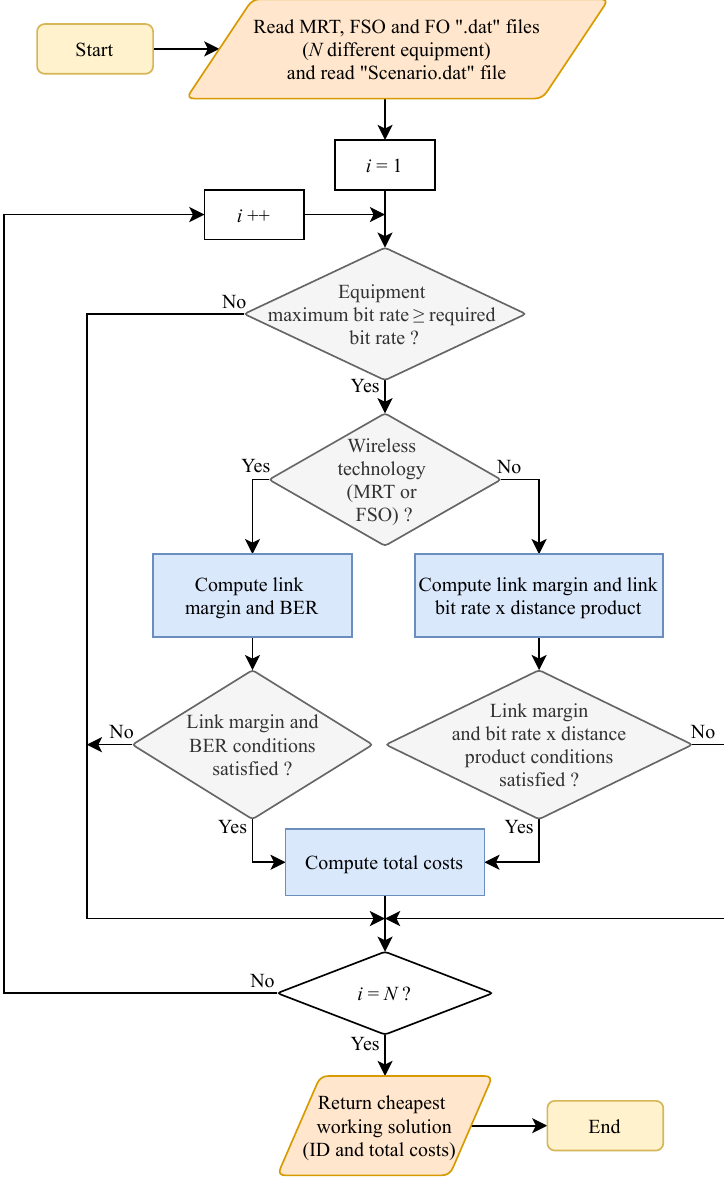
Figure 2. Flowchart of the link design